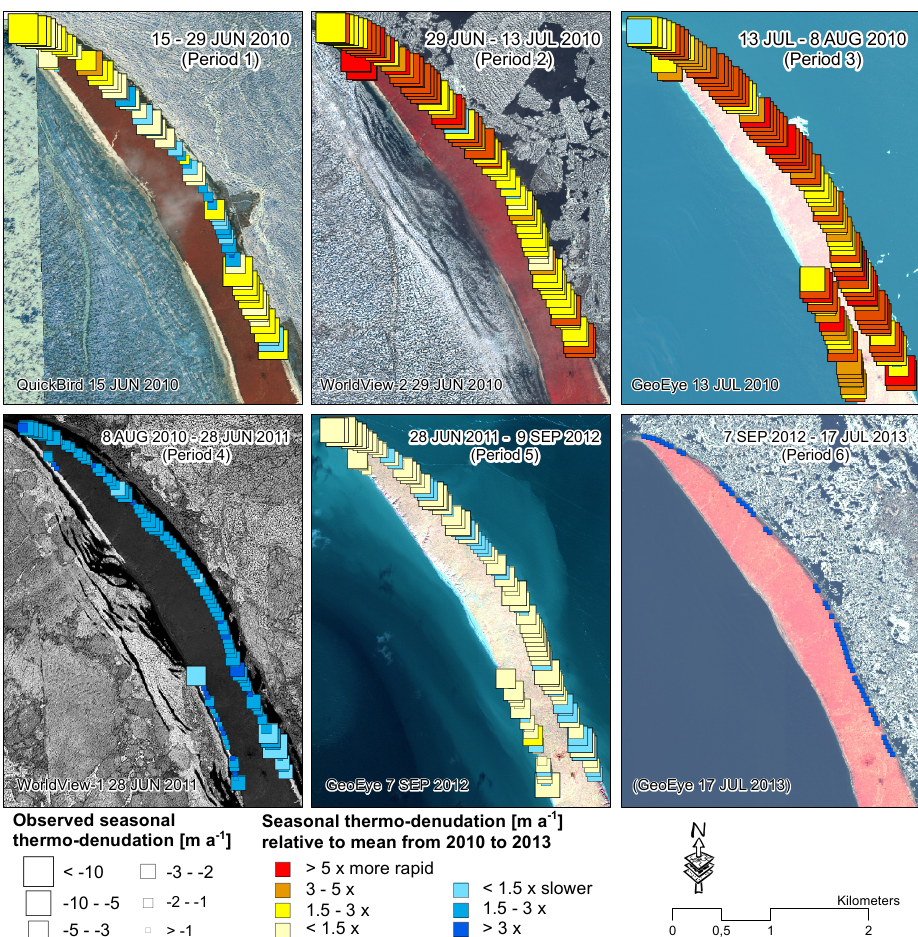
Figure 16. TD during current observation periods from 2010 to 2013 using very high resolution remote sensing data. Symbol size is equiv- alent to season-factor-corrected TD rates in metres per year (periods1–6), colour coding expresses proportion between observed seasonal TDrates and mean TDrates over the July 2010–July 2013 period. Seasonal observations show differences of varying TD intensities during short summer (period 3) vs. fall (periods 4 and 6), while interannual observations revealed homogeneous erosion (period